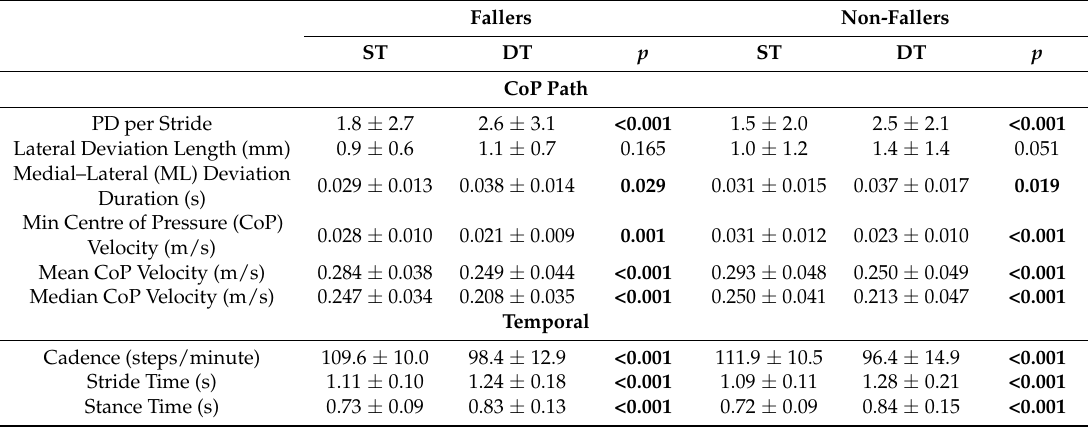
Table 1. Means and SD for pressure-sensing insole variables with a significant ( p < 0.05) mixed-design ANOVA result (Supplementary Table S1). Bold p -values indicate a significant difference between single-task (ST) and dual-task (DT) conditions after correction for multiple